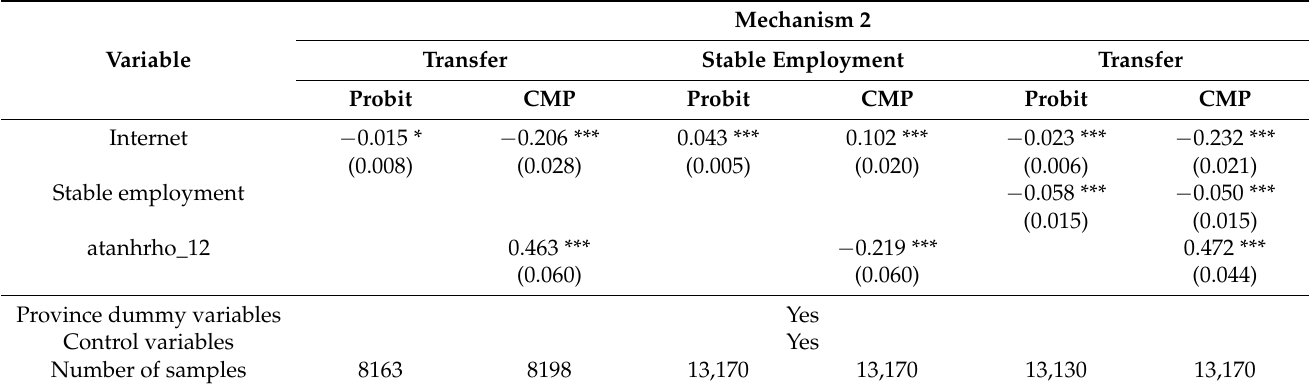
Table 8. Mechanism analysis results of non-agricultural employment